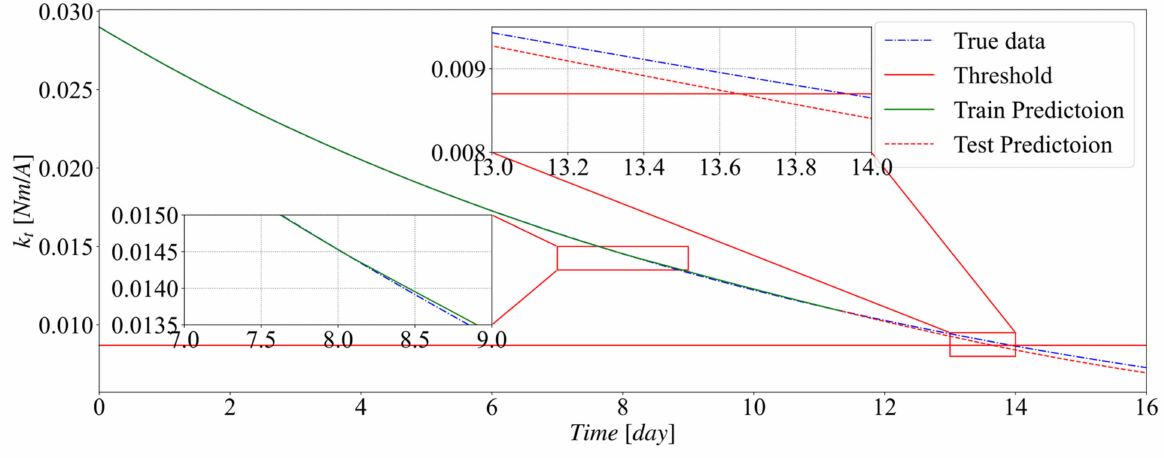
Figure 16. Predicted HI parameter and RUL for days